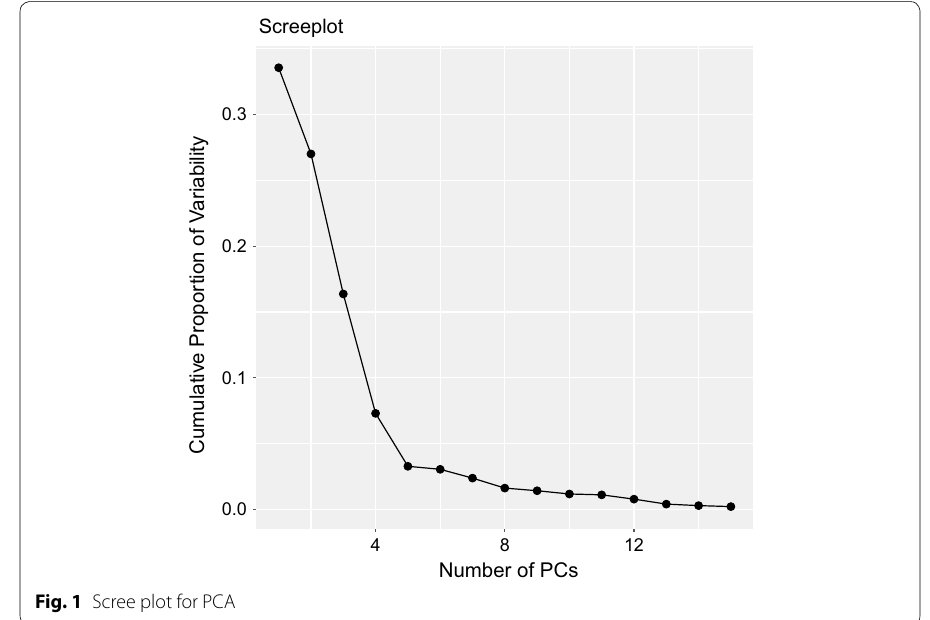
Fig. 1 Scree plot for